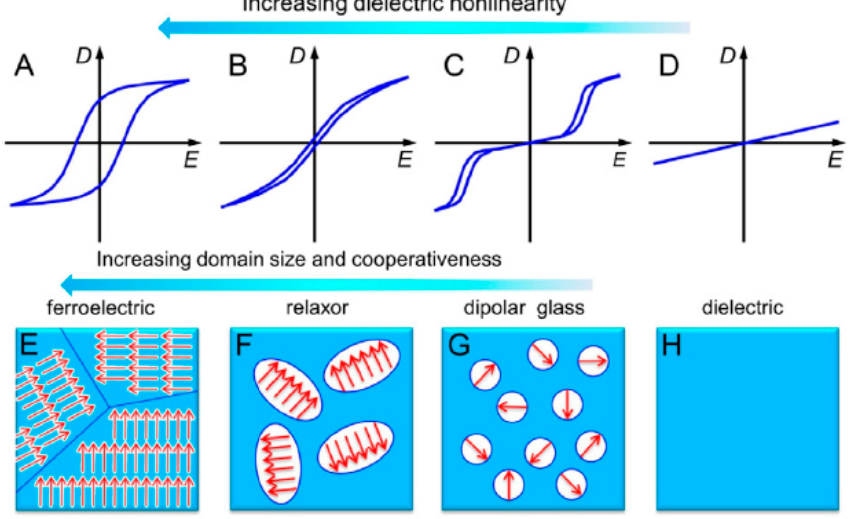
Figure 2. Representative illustrations of the hysteresis loops for ( A ) ferroelectric, ( B ) relaxor ferroelectric, ( C ) dipolar glass and ( D ) dielectric materials. The physical phenomena associated with these behaviors are represented in ( E ) to ( H ), respectively. Note that from ( E ) to ( H ), the polar domain size gradually decreases. Reprinted with permission from reference [8]. Copyright 2013, Elsevier.